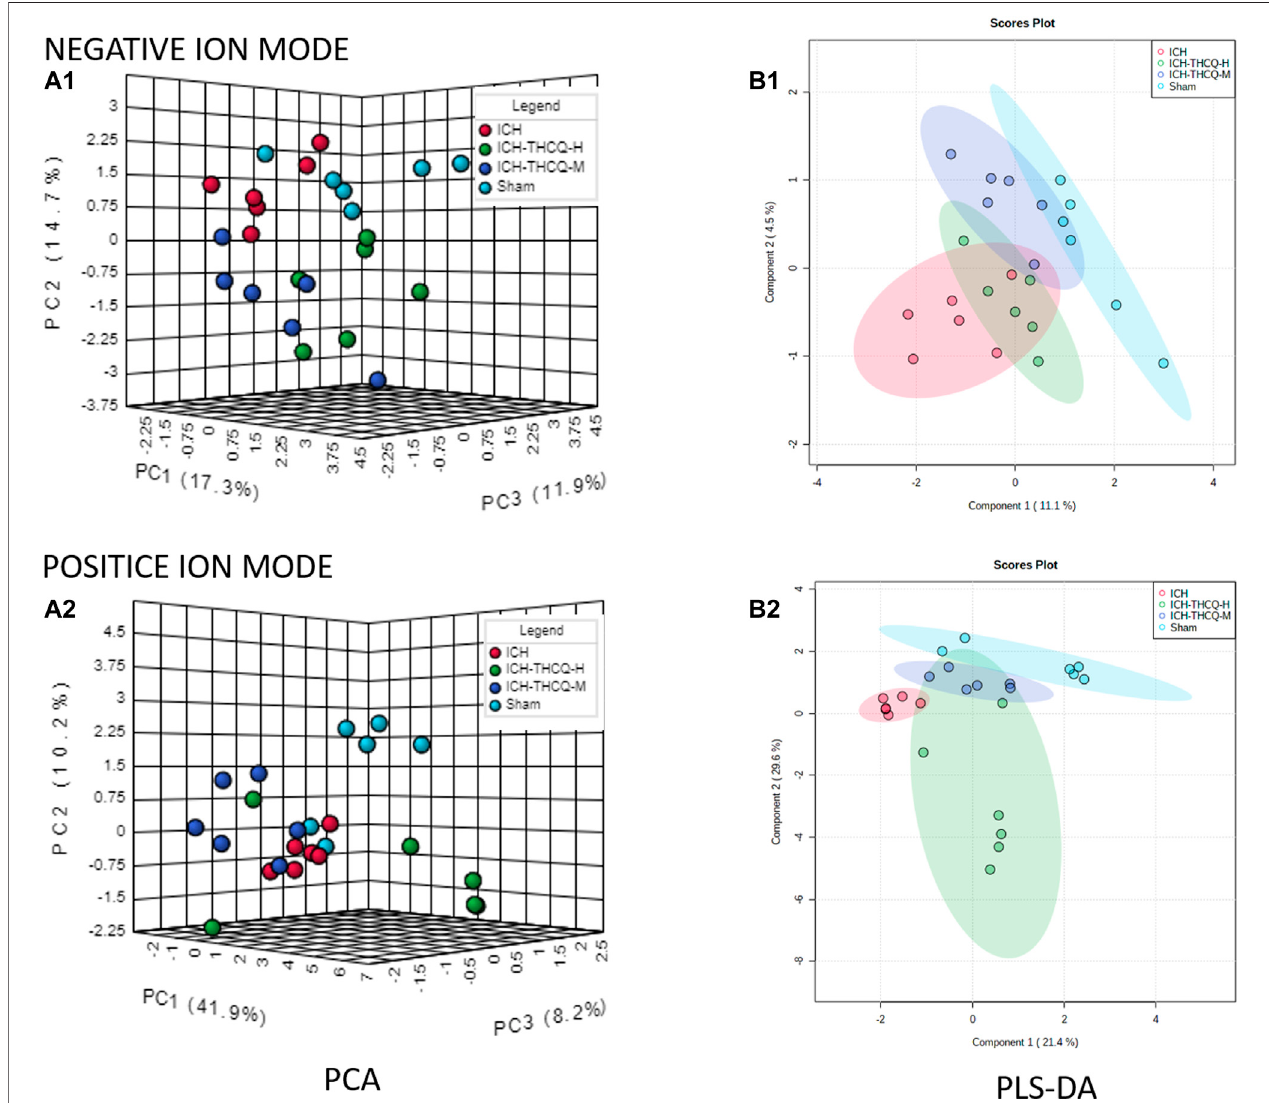
FIGURE5| Discriminationoftheserummetabolicpro fi leamongthesham,ICH,ICH+THCQ-H,andICH+THCQ-Mrats. (A1,A2) PCAscoreplotsinnegativeand positive ion modes, respectively. (B1, B2) PLS-DA score plots in negative and positive ion modes, respectively, n (cid:2) 6 per group.